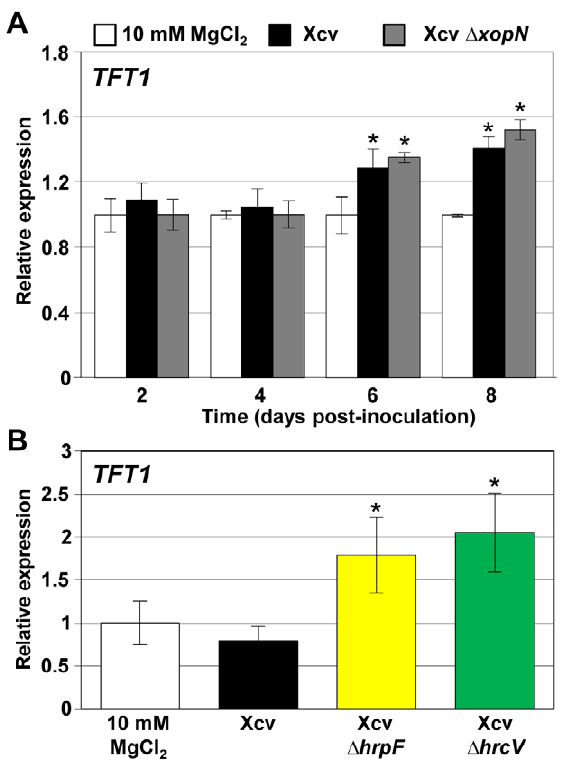
Figure 1. TFT1 is a PTI-induced gene in tomato. ( A ) Susceptible VF36 tomato leaves were inoculated with 10 mM MgCl 2 (white bars), 1 6 10 5 CFU/mL of Xcv (black bars), or Xcv D xopN (grey bars). ( B ) Susceptible VF36 tomato leaves were inoculated with 10 mM MgCl 2 (white bars), 2 6 10 8 CFU/mL of Xcv (black bars), Xcv D hrpF (yellow bars), or Xcv D hrcV (green bars). Total RNA was isolated at 2, 4, 6, and 8 DPI ( A ) or 6 HPI ( B ). Q-PCR was performed to monitor TFT1 mRNA levels. Actin expression was used to normalize the expression value in each sample, and relative expression values were determined against the average value of the sample infiltrated with 10 mM MgCl 2 at each time point. Error bars indicate SD for three ( A ) and four ( B ) plants. Asterisk indicates significant difference ( t test, P , 0.05) relative to the 10 mM MgCl 2 control at 6 or 8 DPI ( A ) or 6 HPI ( B ).